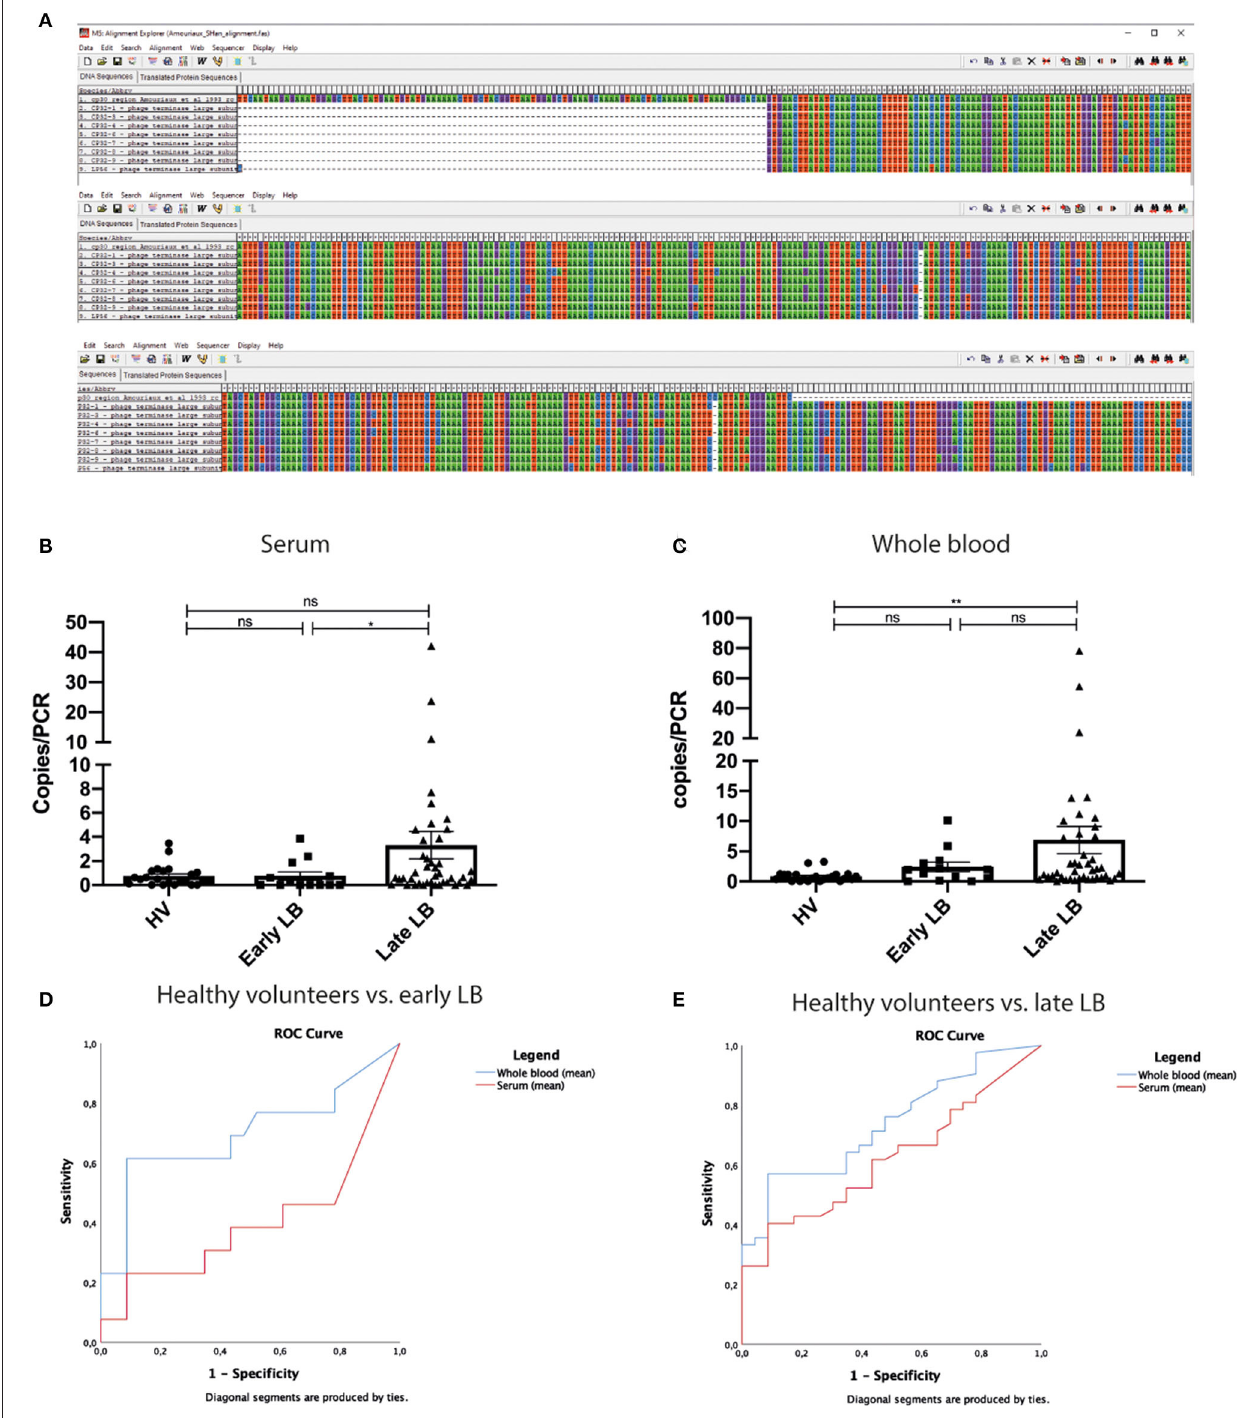
FIGURE 1 | Alignment, individuals values of copies/PCR, and ROC analysis of copies/PCR. (A) Sequences published by Amouriaux et al. (1993) and by Shan et al. (2021) (termed cp32-1 to cp32-9 and lp56, lines 2–9) were aligned in MEGA 5 (Tamura et al., 2011). The alignment shows that there is some overlap between these sequences. The overlap starts at position 102 into the sequence published by Amouriaux et al. (1993) (first line) and continues until pos 420. Dashes indicate the end of sequence used by Amouriaux. There are only two mismatches to cp32-1 and these are single base insertions. These data indicate that the cp32 terminal phage subunit gene region was already used as a target for diagnostic Borrelia PCR prior to the publication by Shan et al. (B,C) Even though the mean value of copies/PCR are significantly different in our analysis between late LB and healthy individuals, there is significant overlap between all groups. This was observed both in serum and